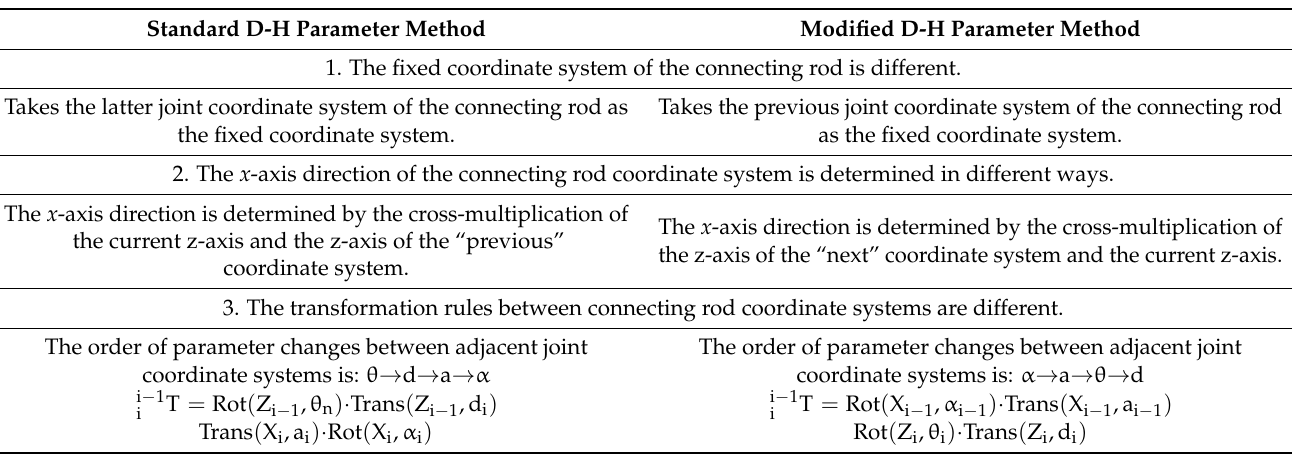
Table 1. Difference between standard D-H parameter method and modified D-H parameter method.